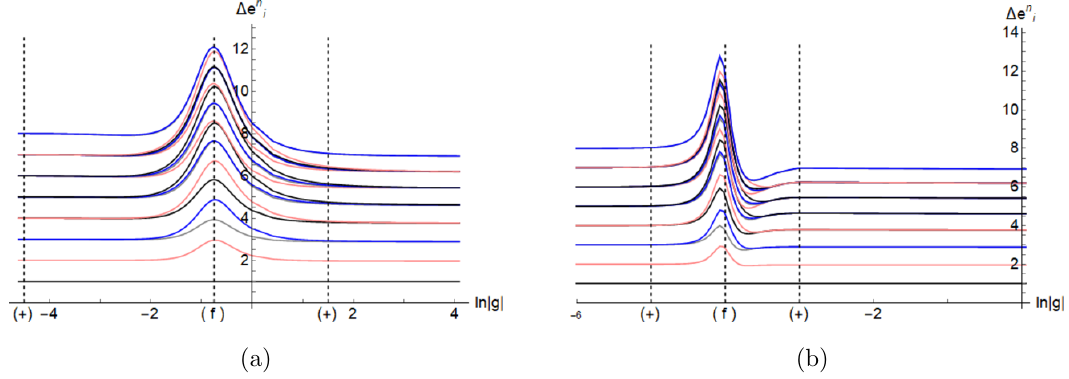
Figure 14. (a) T perturbation of the Ramond Fixed point with positive coupling with (cid:1) max = 26; (b) T perturbation of the Ramond Fixed point with negative coupling with (cid:1) max =